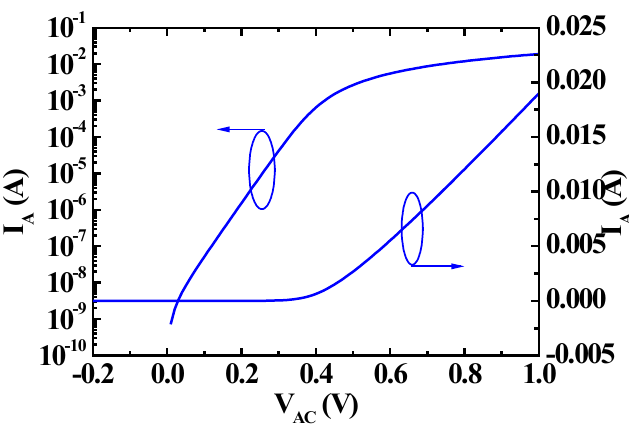
Figure 2. Simulated DC response of the Schottky barrier diode (SBD) with dimension of 1 μ m × 0.3 μ m.